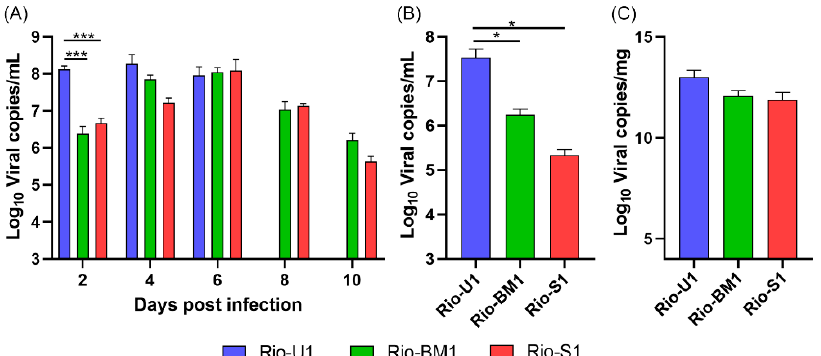
Figure 8. ZIKV viral load after inoculation of AG129 mice with ZIKV isolates. ( A ) Blood viremia in the 2, 4, 6, 8, and 10 days post-infection and at ( B ) the moment of death in the blood and ( C ) in the brain. * Represents p ≤ 0.05, and *** Represents p ≤ 0.001.